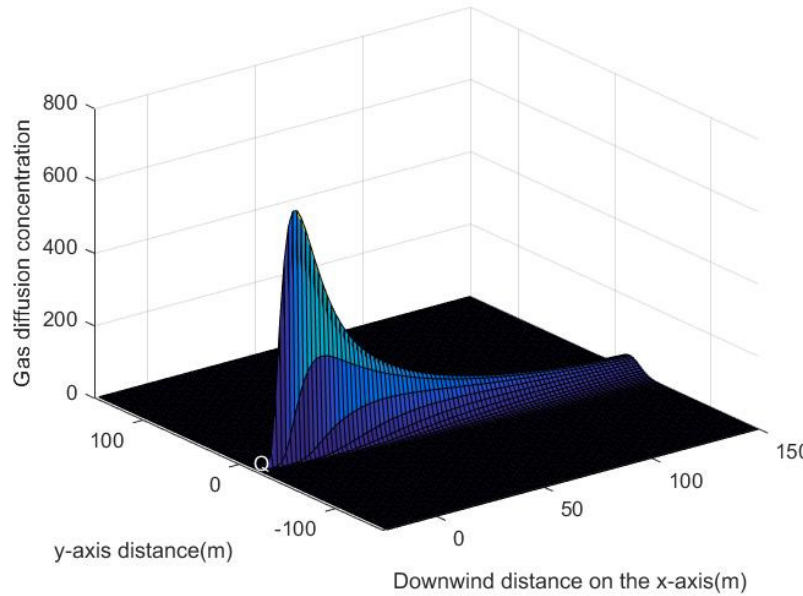
Figure 2. Continuous leakage diagram of single-point sources in a 3D space.